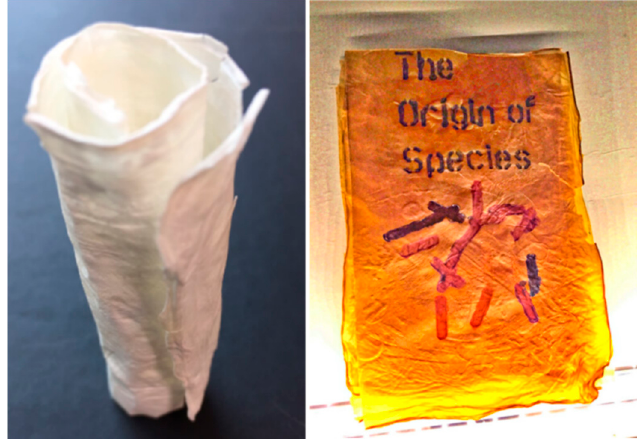
Figure 8. Paper produced with bacterial cellulose [183].